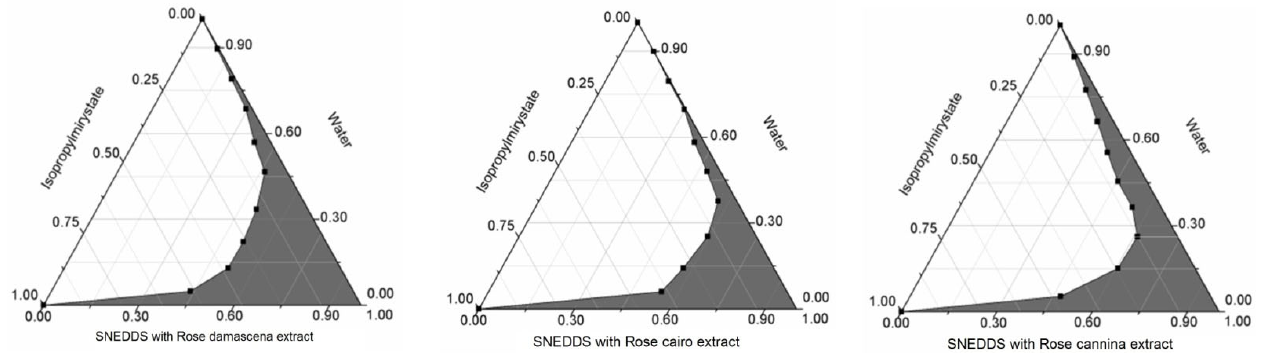
Figure 1. Pseudoternary phase diagrams of the different compositions. The dark area shows the nanoemulsion zone of the preparations.